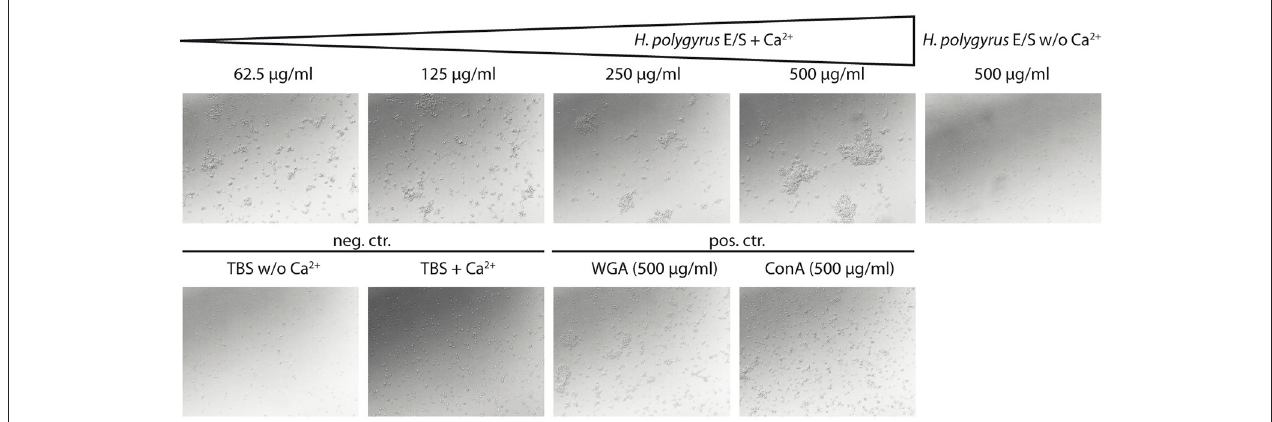
FIGURE 1 | H. polygyrus excretory/secretory products cause bacterial agglutination. (Top) Bacterial agglutination in the presence and absence of native adult H. polygyrus E/S products (HES) and 10mM CaCl 2 . Representative images of agglutination of E. coli IMT19224 with serial dilutions of H. polygyrus E/S products are shown. (Bottom) controls of agglutination include tris-buffered saline (TBS) with and without CaCl 2 as well as the C-type lectins wheat germ agglutinin (WGA) and concanavalin A (Con A). Magnification x400. Data are representative for two individual experiments performed with two independent HES batches.